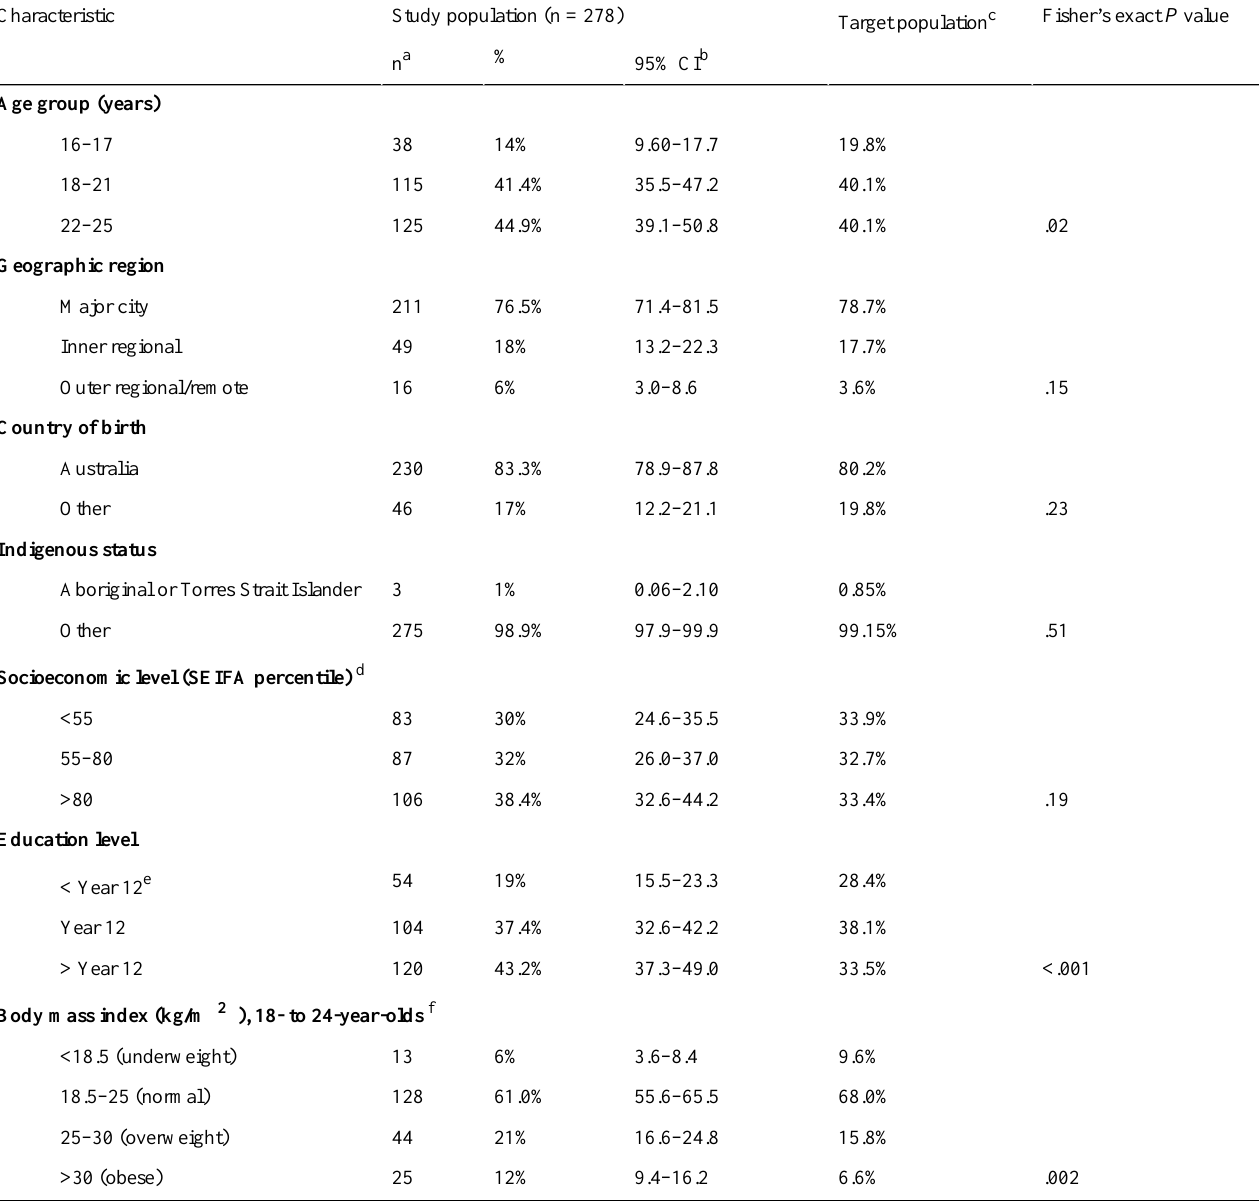
Table 3. Demographic characteristics of